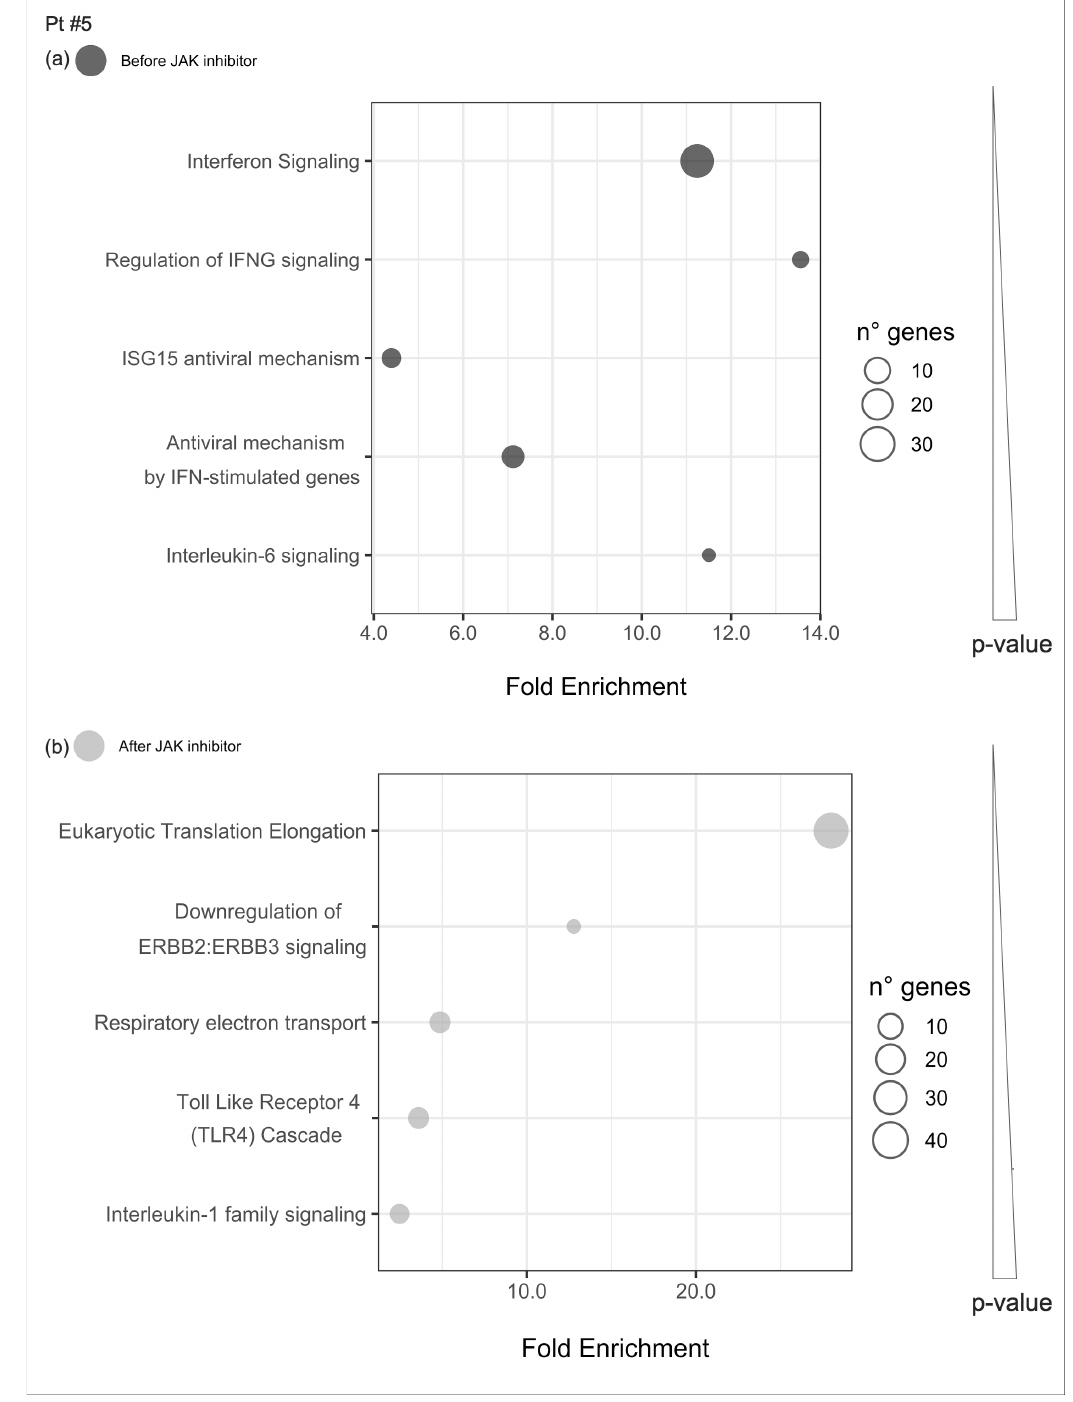
Figure 12. Pathway enrichment analysis was run on di ff erential expressed genes resulting from the comparison between patient #5 before JAKinhibs and the control-group subjects, and between patient #5 after JAKinhibs and the controls. Pathways altered uniquely before ( a ) or uniquely after ( b ) JAKinhibs were chosen. Each dot represents a pathway, and the size is directly proportional to the number of genes. On the X -axis the pathway fold enrichment is displayed. All the selected pathways showed a lowest adjusted p -value of the given term over all iterations ≤ 0.01, and the five most enriched pathways were elected, where applicable. Pathways are ordered by increasing p -values. Pathways altered before JAKinhibs are colored in dark grey and those altered after JAKinhibs in light